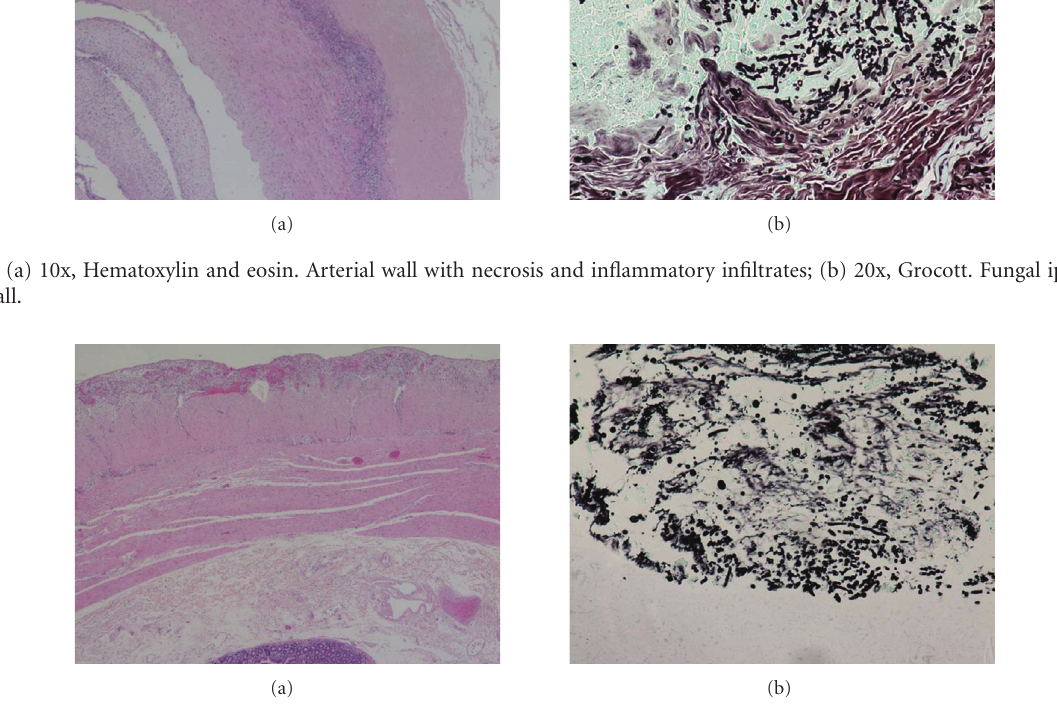
Figure 2: (a) 10x, Hematoxylin and eosin. Phlogosis of the intestinal sierosa; (b) 20x, Grocott. Fungal iphae in the arterial